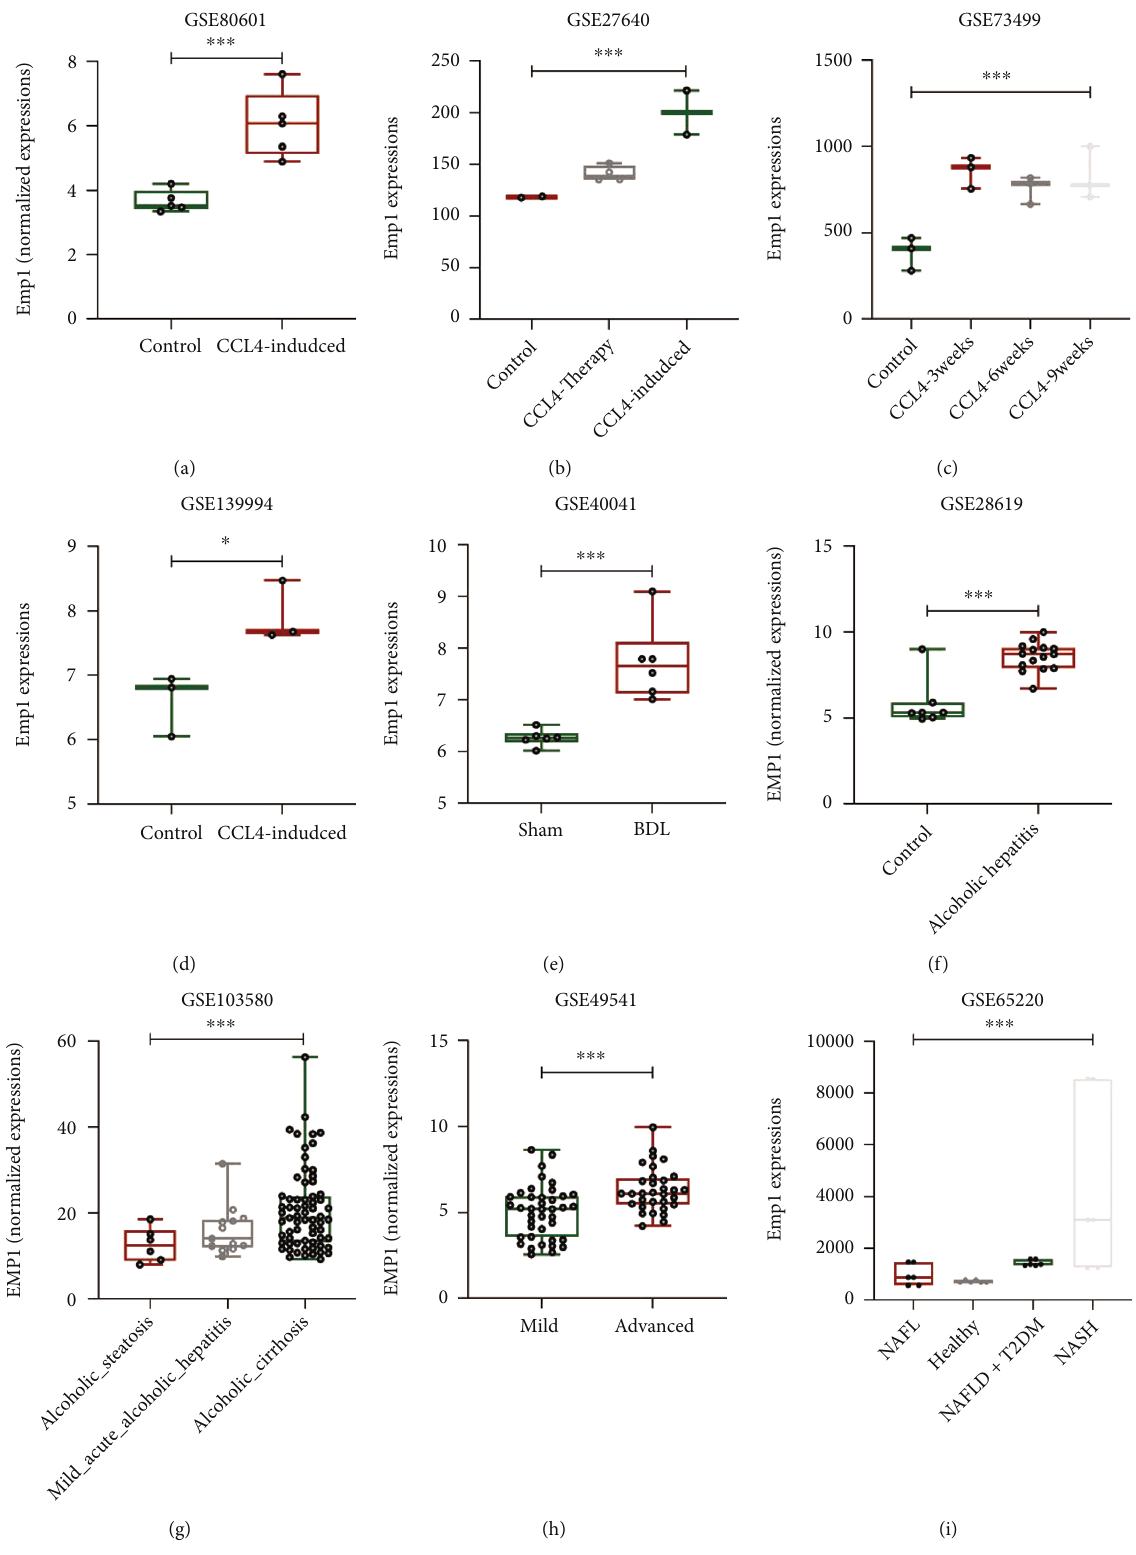
Figure 3: EMP1 is a marker gene for fi brotic liver in both animal and human samples. Emp1 upregulation in CCl -treated mouse liver samples 4 comparedwithnormaltissuesinGSE80601 (a),GSE27640 (b),GSE73499 (c),andGSE139994(d). Emp1 expressionelevationinmiceBDLmodel compared with sham group (e). Positive association of EMP1 expression with alcoholic hepatitis (GSE28619) (f) and alcoholic cirrhosis (GSE103580) samples (g). Increased expression of EMP1 in liver samples with advanced stage of fi brosis (stage 3 – 4) compared with mild (stage 0 – 1) (h). In the rat model, Emp1 expression is greatest in the NASH group compared to the NAFL, NAFLD+T2DM, and healthy , carbon tetrachloride; EMP1, epithelial membrane protein 1; NAFL, nonalcoholic fatty liver; control groups. BDL, bile duct ligation (i); CCl 4 NAFLD, nonalcoholic fatty liver disease; NASH, nonalcoholic steatohepatitis; T2DM, type 2 diabetes; * P < 0 : 05 and *** P < 0 : 01